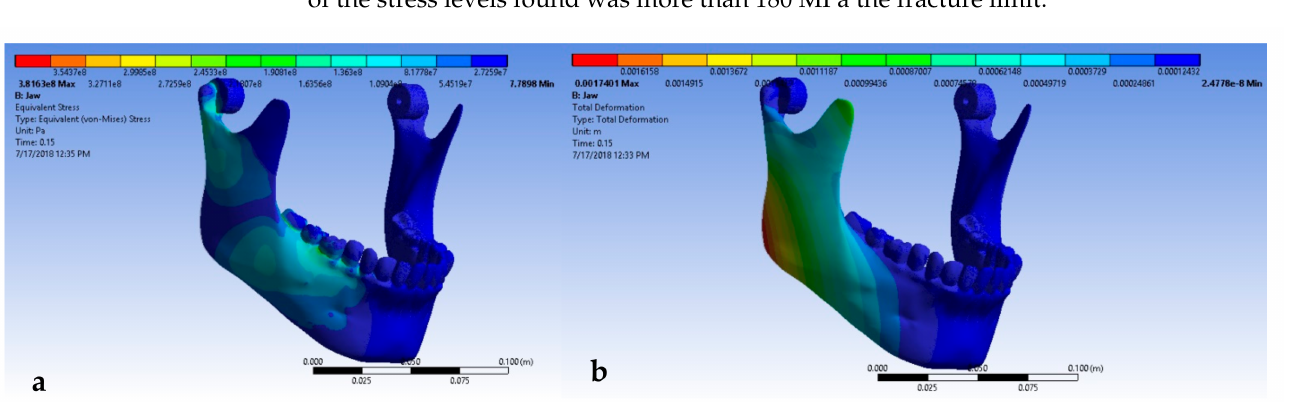
Figure 9. Equivalent ( a ) stress distributions (unit: Pa) and ( b ) total deformation (unit: Pa) on the mandible’s surface in the event of a lateral impact with complete dentition: equivalent (von Mises stress) stress, time: 0.15